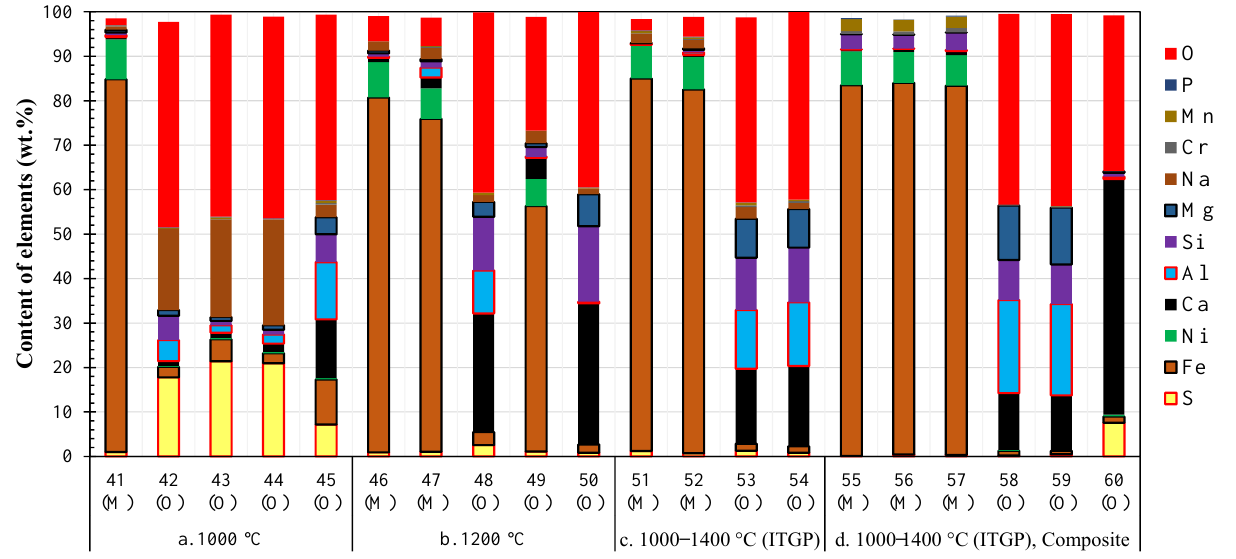
Figure 11. EDS analysis of roasted natrojarosite briquettes after carbothermic reduction at different temperatures; IGTP = isothermal gradient temperature profile. Numbers 41 – 60 refer to the location in Figure 10.